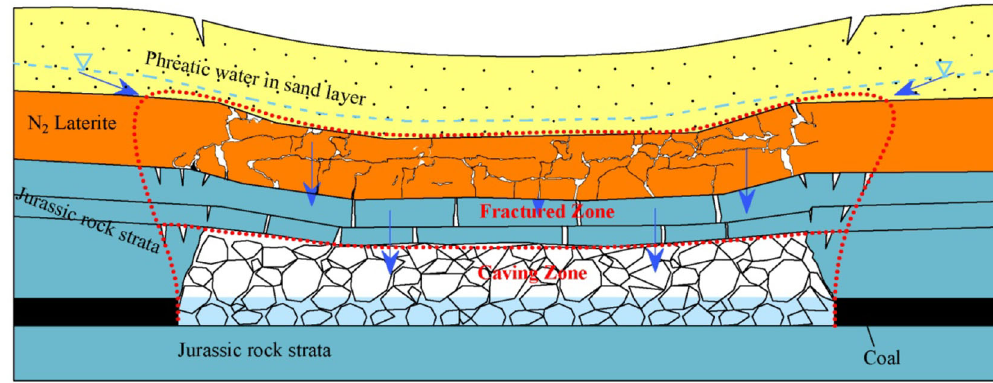
Fig. 3 Typical cross-sectional schematic for a western coal field